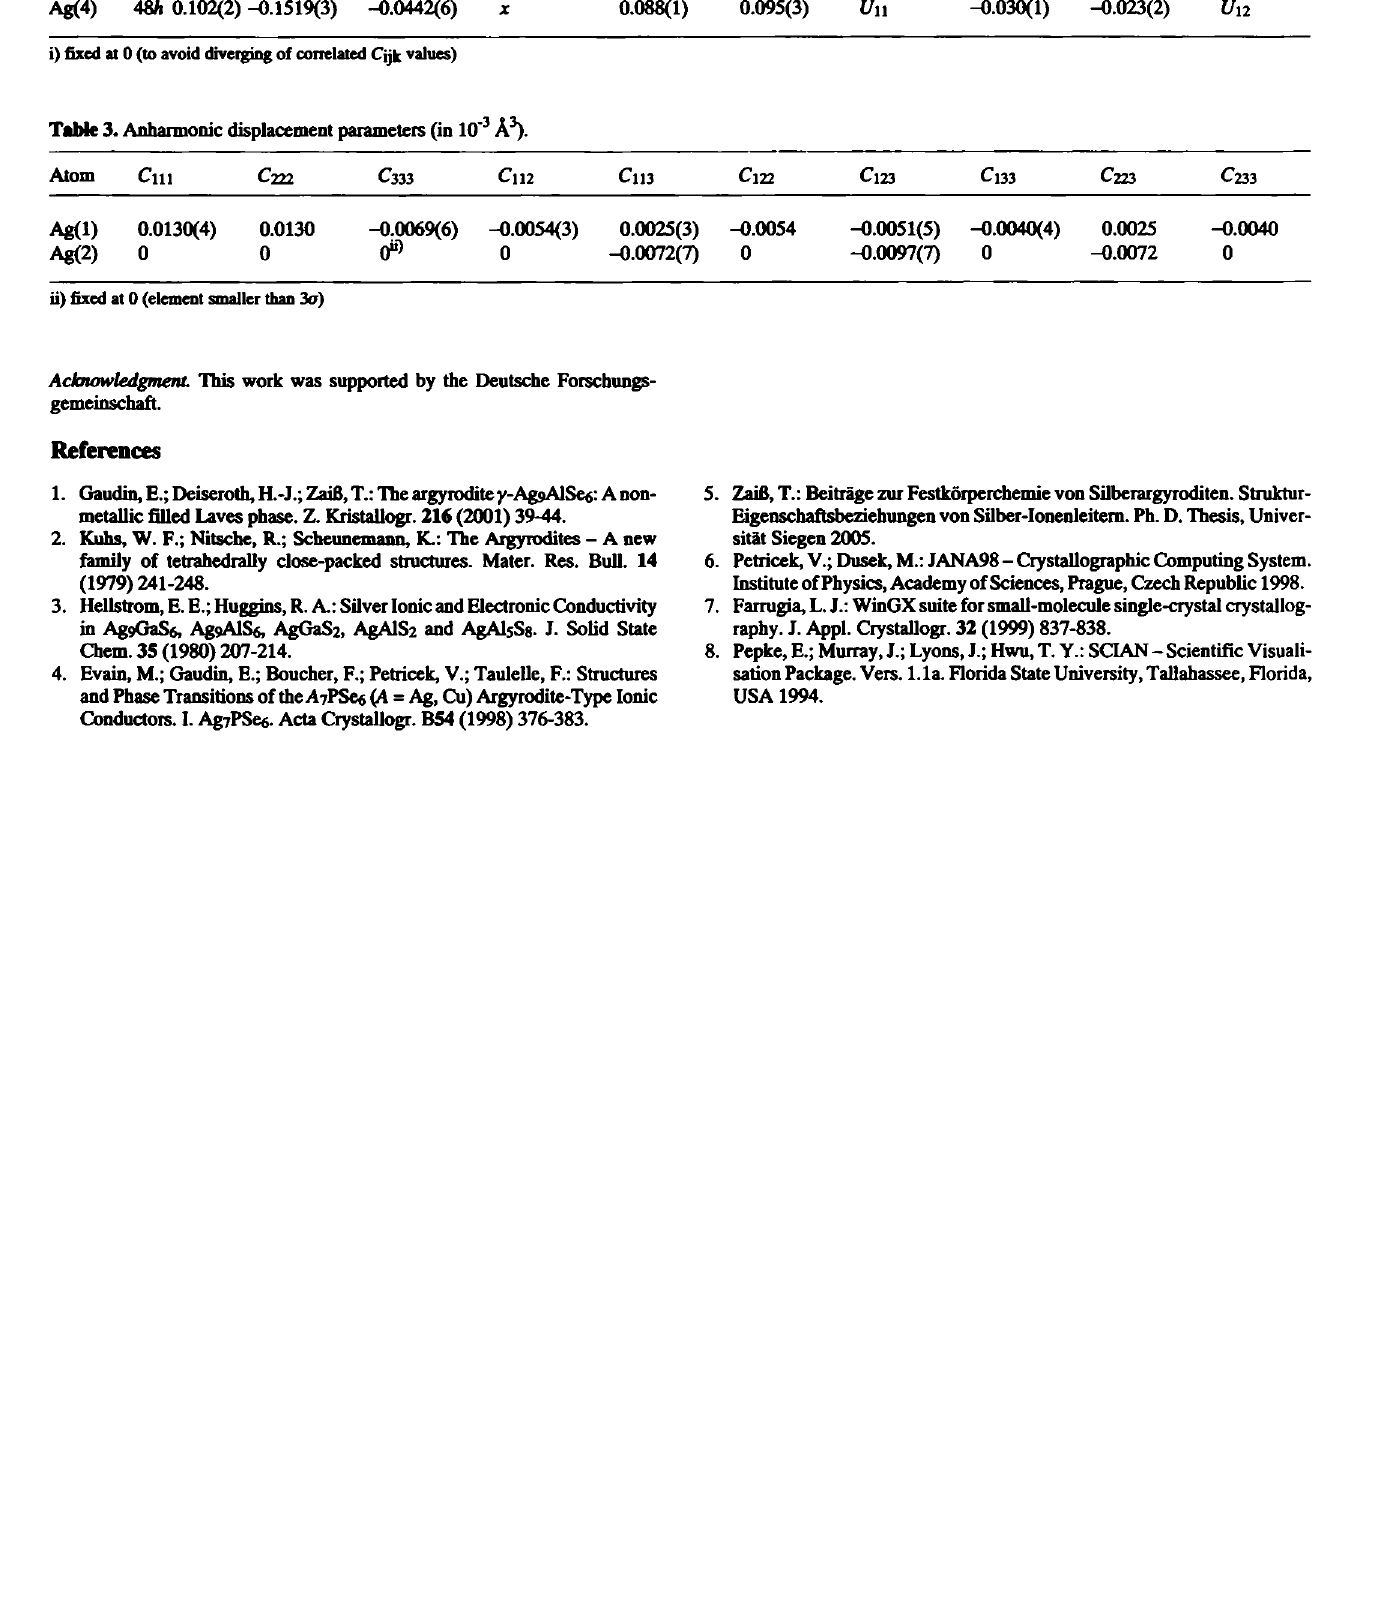
Table 3. Anharmonic displacement parameters (in 10~ 3 A 3